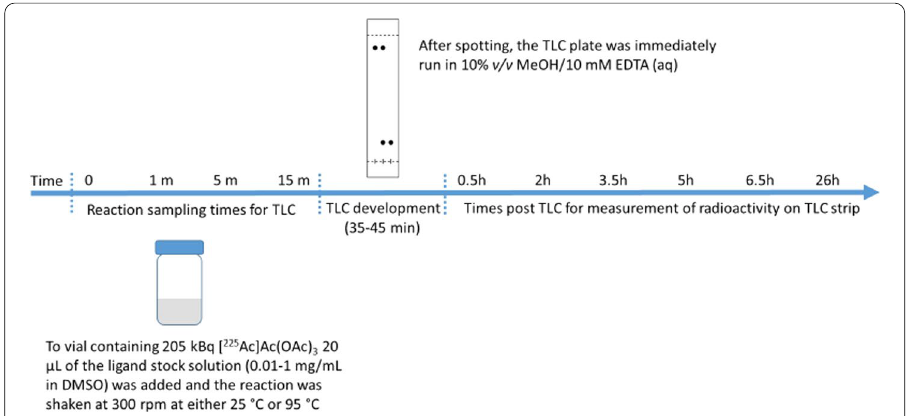
Fig. 1 Description of the experiment and method of measuring radiochemical